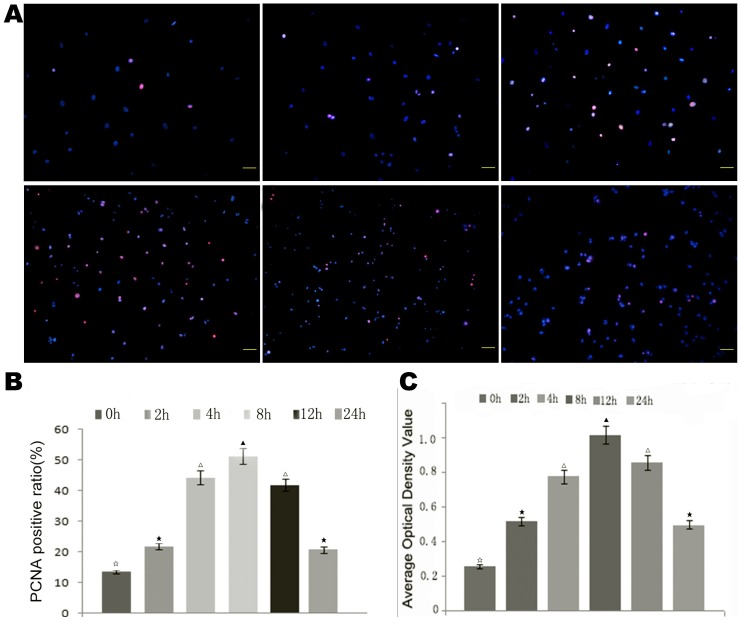
AngII treatment promoted proliferation of HUVECs.AngII treatment was shown to promote HUVEC proliferation by immunofluorescence staining of PCNA and MTT assays. (A) Immunofluorescence staining of PCNA of HUVECs in each group. (B) Semi-quantitative analysis of the immunofluorescence staining of PCNA. (C) Shows the statistical analysis of MTT assays for each group. Different symbols indicate statistical significance (p<0.05).